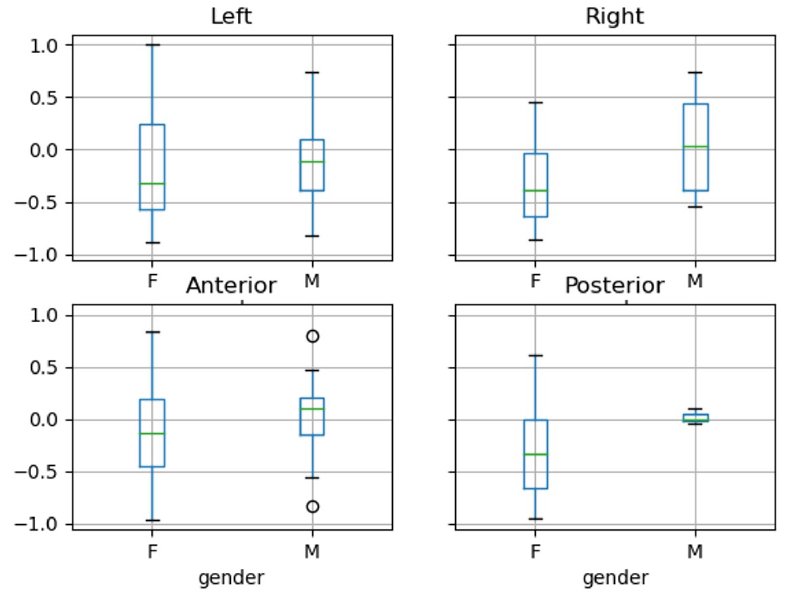
Figure 2. Plot of Spearman’s correlation between perceptions of sexism and beta coefficients by gender for each